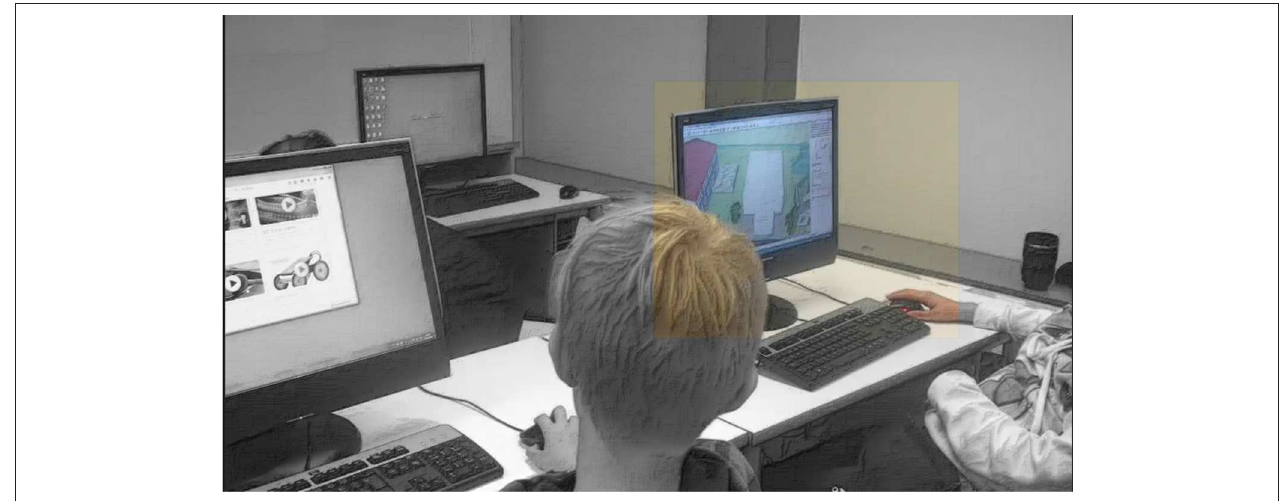
FIGURE 4 | Students working on the dream home design challenge.